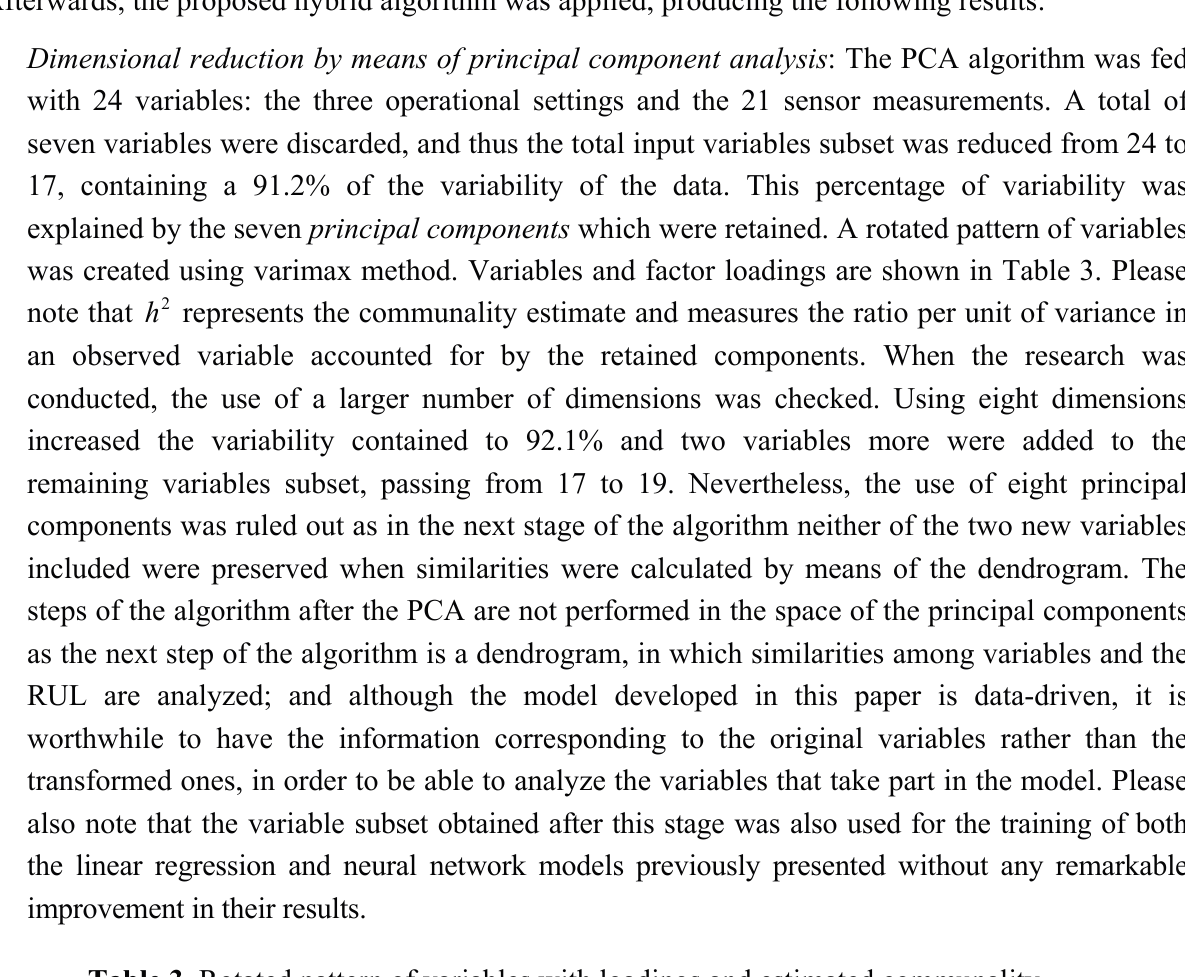
Table 3. Rotated pattern of variables with loadings and estimated